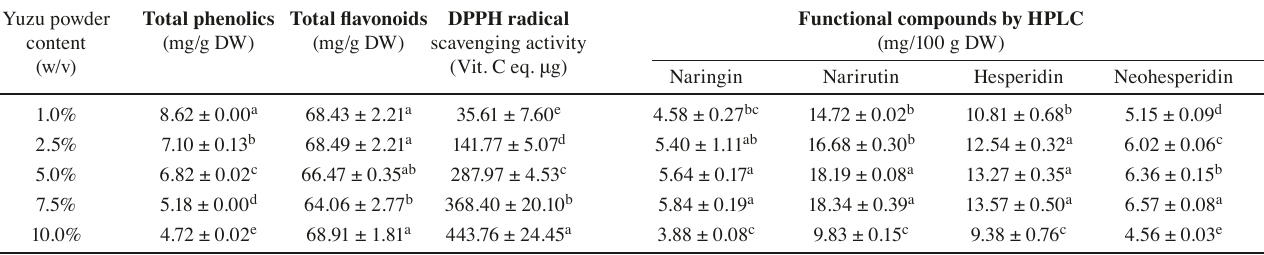
Tab. 2: Functional components of yuzu extracts by yuzu powder content.